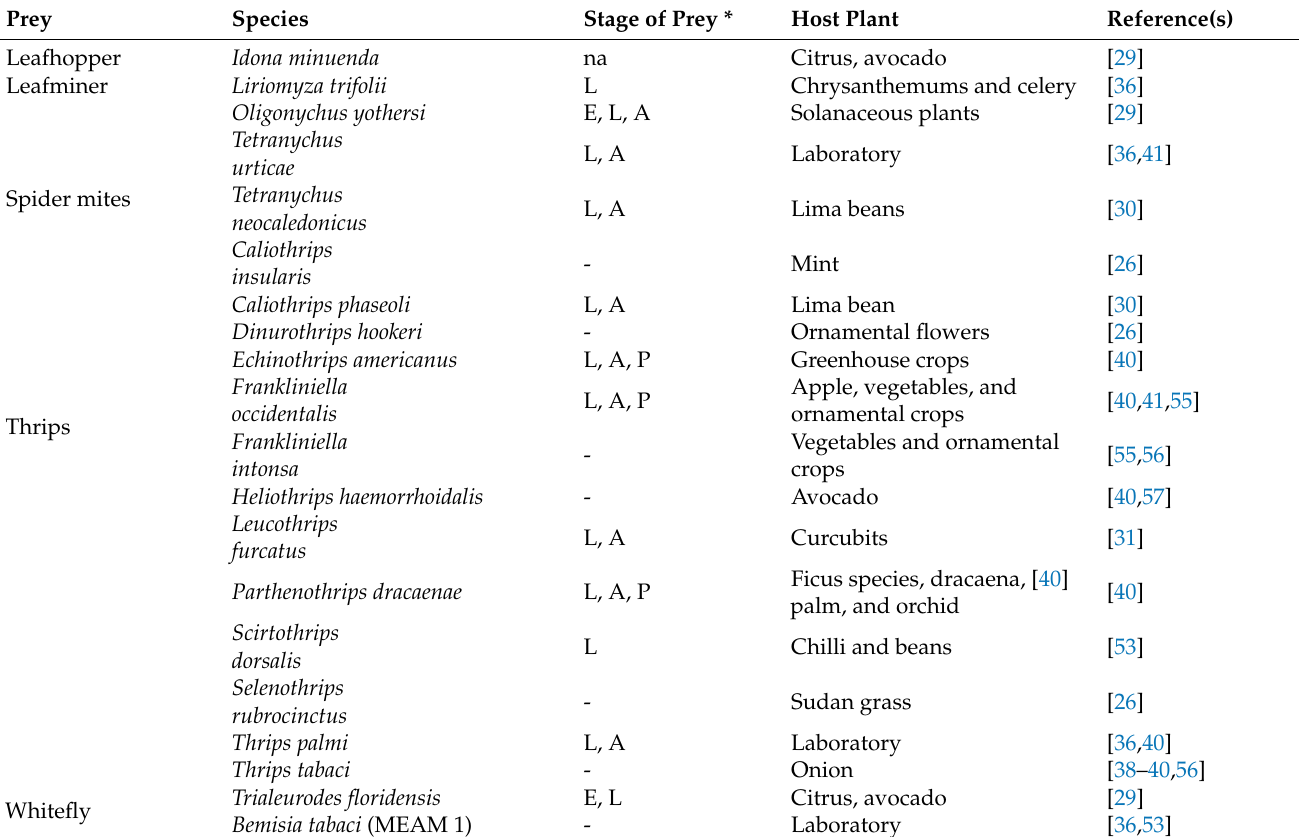
Table 3. Known prey and associated host plant associations for Franklinothrips vespiformis